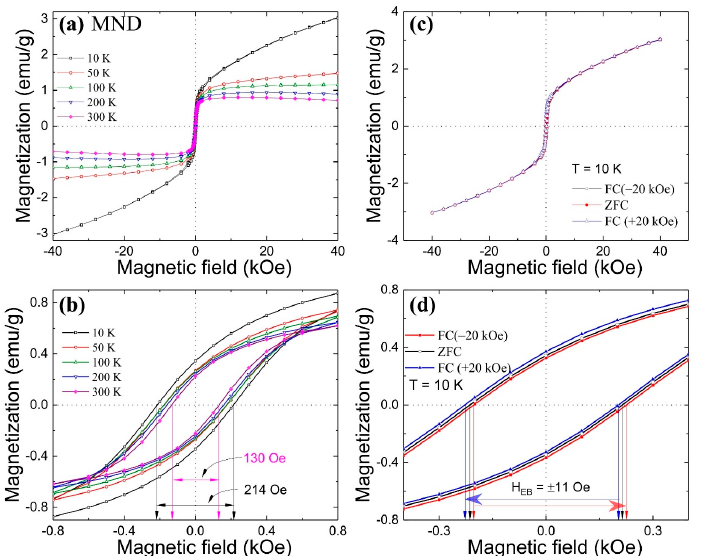
Figure 2. ( a ) zero field cooled (ZFC) M(H a ) loops measured at different temperatures from MND, ( b ) Magnified ZFC M(H a ) loops near zero-field. ( c ) ZFC and FC (±20 kOe) M(H a ) loop measured at 10 K. ( d ) Magnified ZFC and FC M(H a ) loop near zero-field.